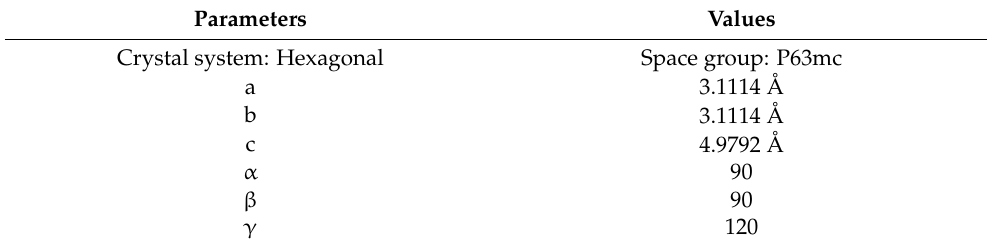
Table 1. Crystallographic parameters of deposited Ni-doped AlN crystal structures.